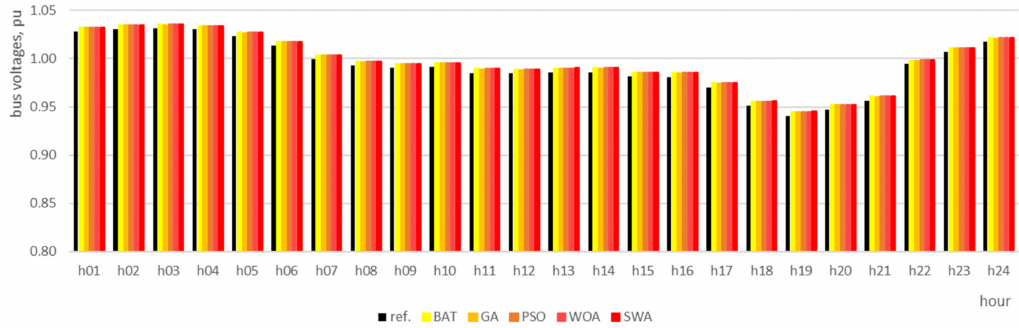
Figure 27. Voltage improvement after compensation for bus 135, medium voltage, the 215-bus